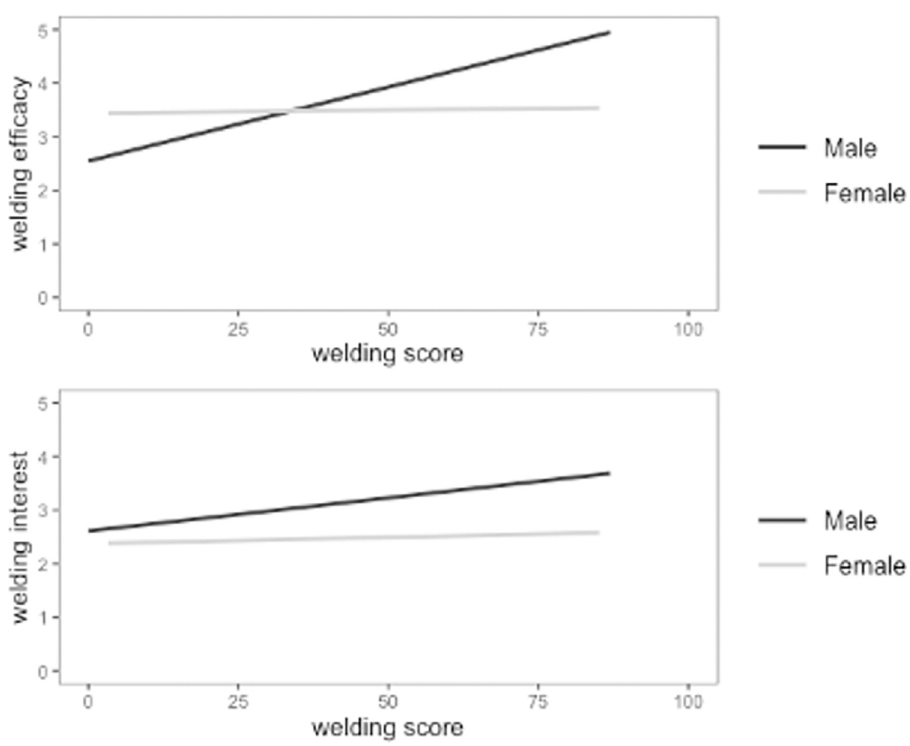
Fig 2. Performance predicts welding self-efficacy and interest stronger for males than females in the VR condition. Interaction effect of gender and performance on welding self-efficacy (top) and interest (bottom) for VR. The darker line represents males and the lighter line represents